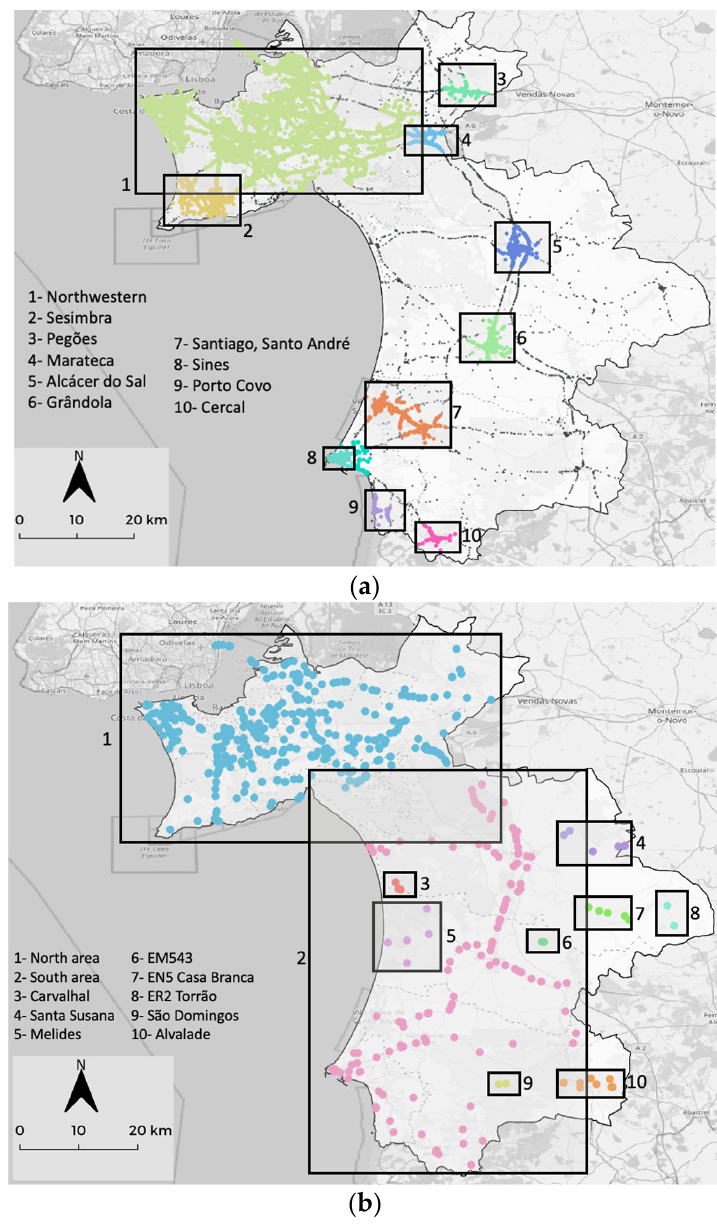
Figure 3. DBSCAN maps for datasets I (all accidents) and II (accidents with serious or fatal victims). ( a ) Dataset I with clusters of at least 85 RTAs and a 2 km maximum distance between neighbors; and ( b ) dataset II with clusters with a minimum of 2 RTAs within a distance of 6 km.